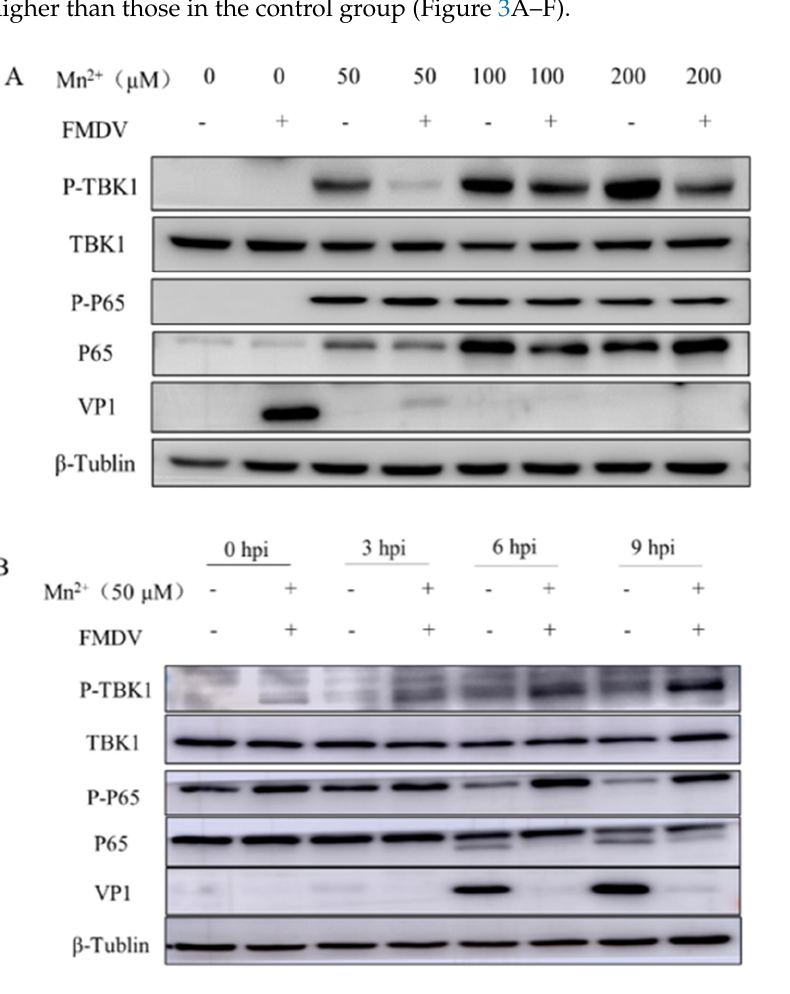
Figure 2. Activation of the NF- κ B signaling pathway in PK15 cells treated with Mn 2+ . ( A ) PK15 cells were treated with 0, 50, 100, and 200 µ M Mn 2+ , respectively, and PK15 cells were collected 8 h after FMDV infection for western blot assay. ( B ) PK15 cells were treated with 50 µ M Mn 2+ , and PK15 cells were collected at 3, 6, and 9 h after FMDV infection for western blot assay.